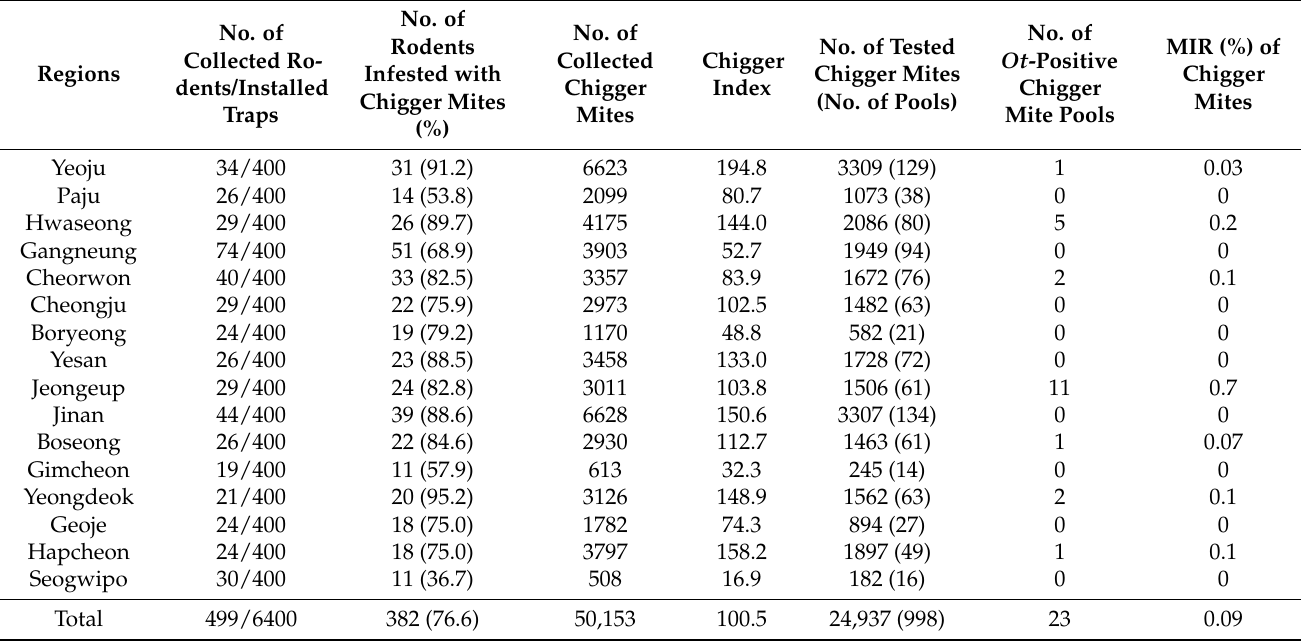
Table 3. Data collection of regions and infections by Orientia tsutsugamushi in chigger mites from wild rodents sampled in the Republic of Korea in